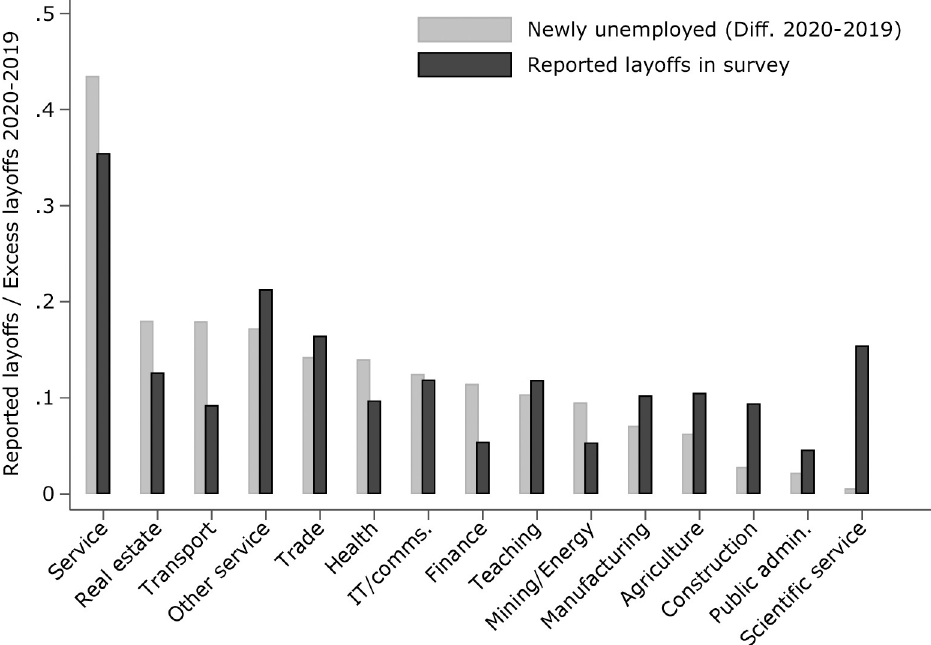
Fig 2. Reported layoffs and official statistics across industries. Note: Fig compares layoffs as reported by the survey respondents over time and across industries and compares them to official statistics. Source: Federal Employment Agency [3], own